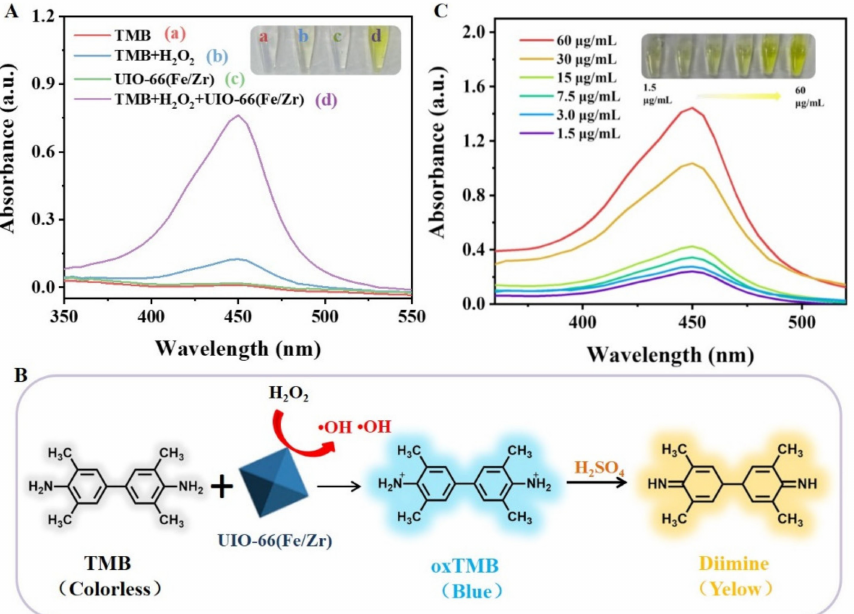
Figure 3. ( A ) UV-vis absorbance spectra of different solution. The insets showing the images of their corresponding solution. ( B ) Schematic illustration of UIO-66(Fe/Zr)-mediated catalytic oxidation of TMB-H 2 O 2 system. ( C ) UIO-66(Fe/Zr) concentration-dependent UV-vis absorbance spectra of TMB-H 2 O 2 system. The insets show the images of their corresponding